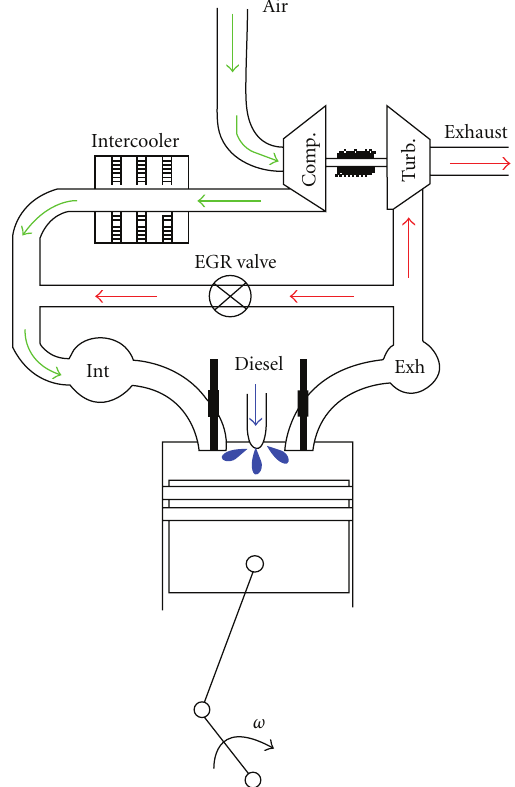
Figure 1: The exhaust gas recirculation system.